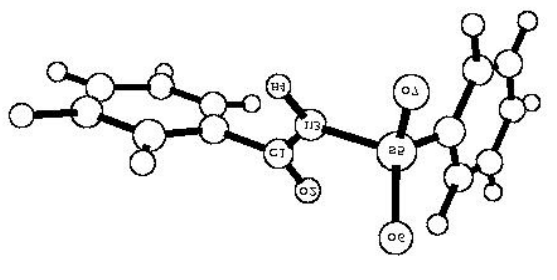
Figure 1. PM3 optimized structure of compound 5